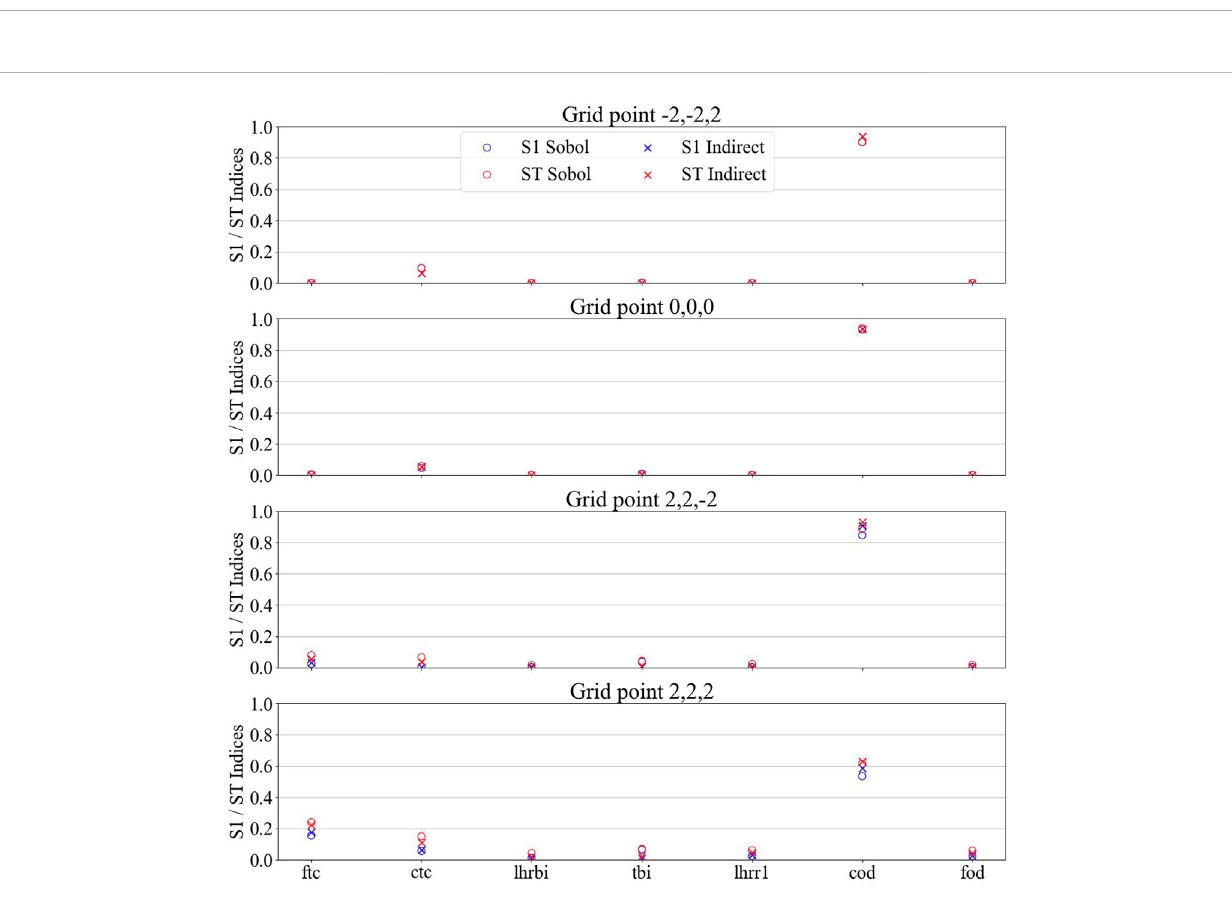
FIGURE 11 First (S1) and total (ST) Sobol indices for the average cladding outer diameter. Sobol means indices were calculated from the Sobol method while indirect means from the surrogate